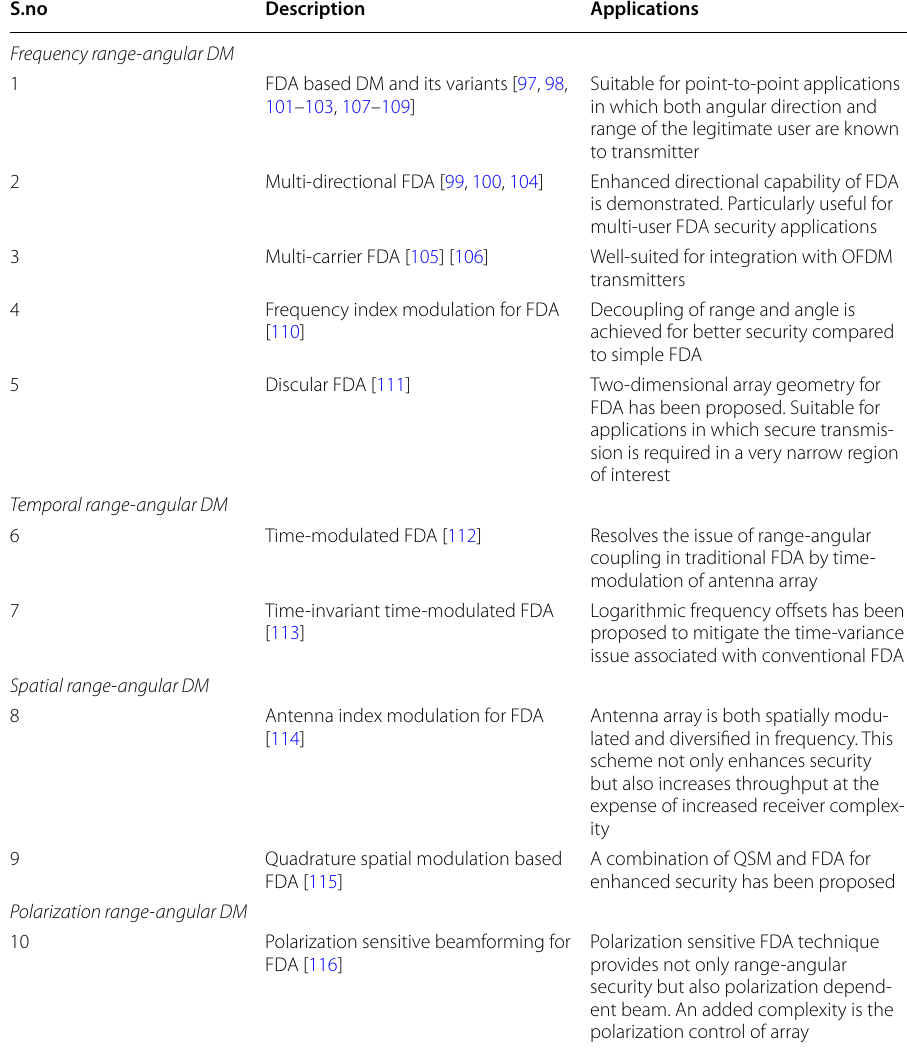
Table 6 Application specific comparison of range-angular DM techniques